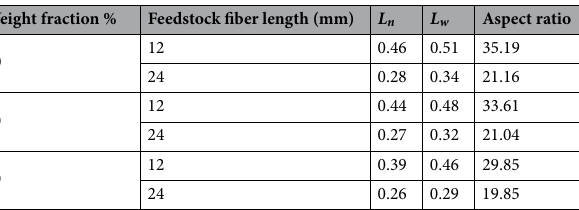
Weight fraction %